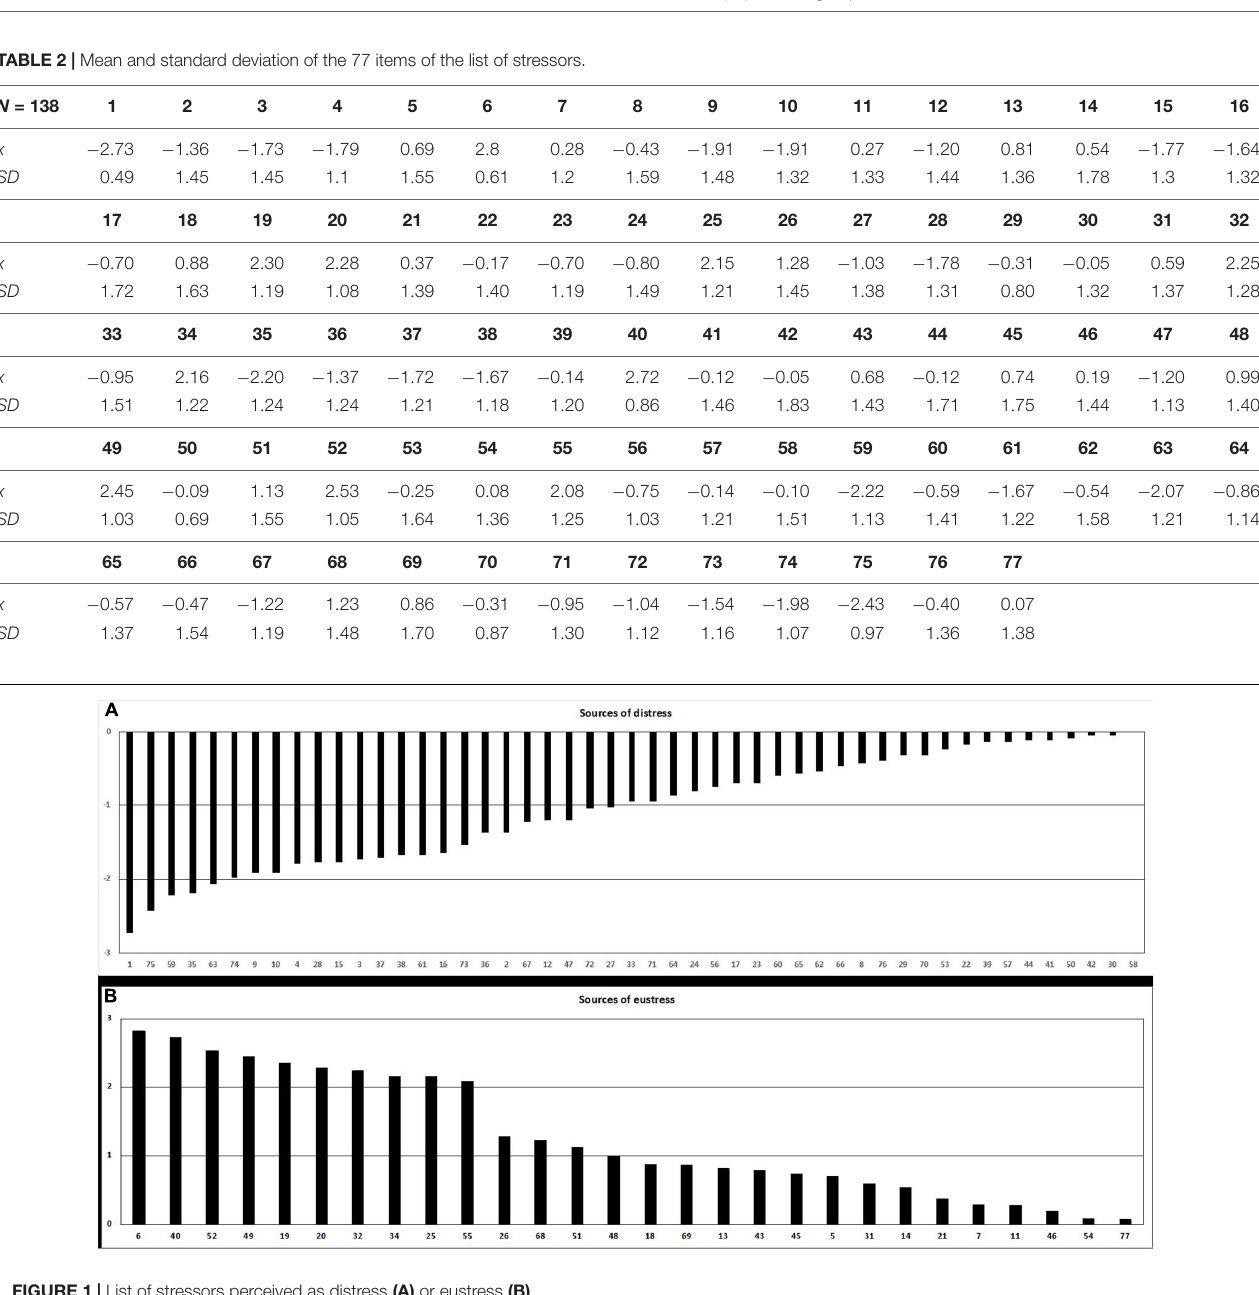
FIGURE 1 | List of stressors perceived as distress (A) or eustress (B)